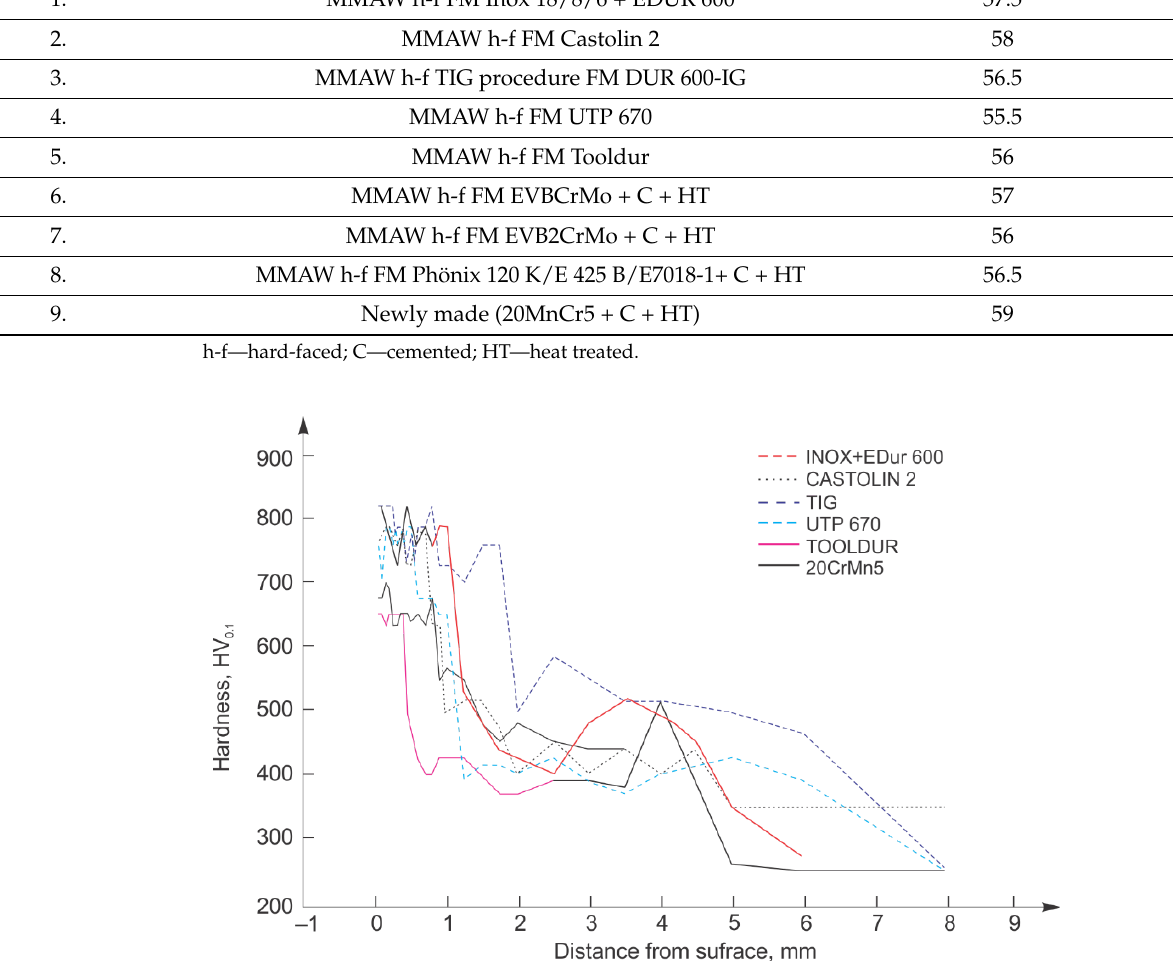
Figure 15. Hardness distribution diagram of samples hard-faced with “ hard ” filler metals.